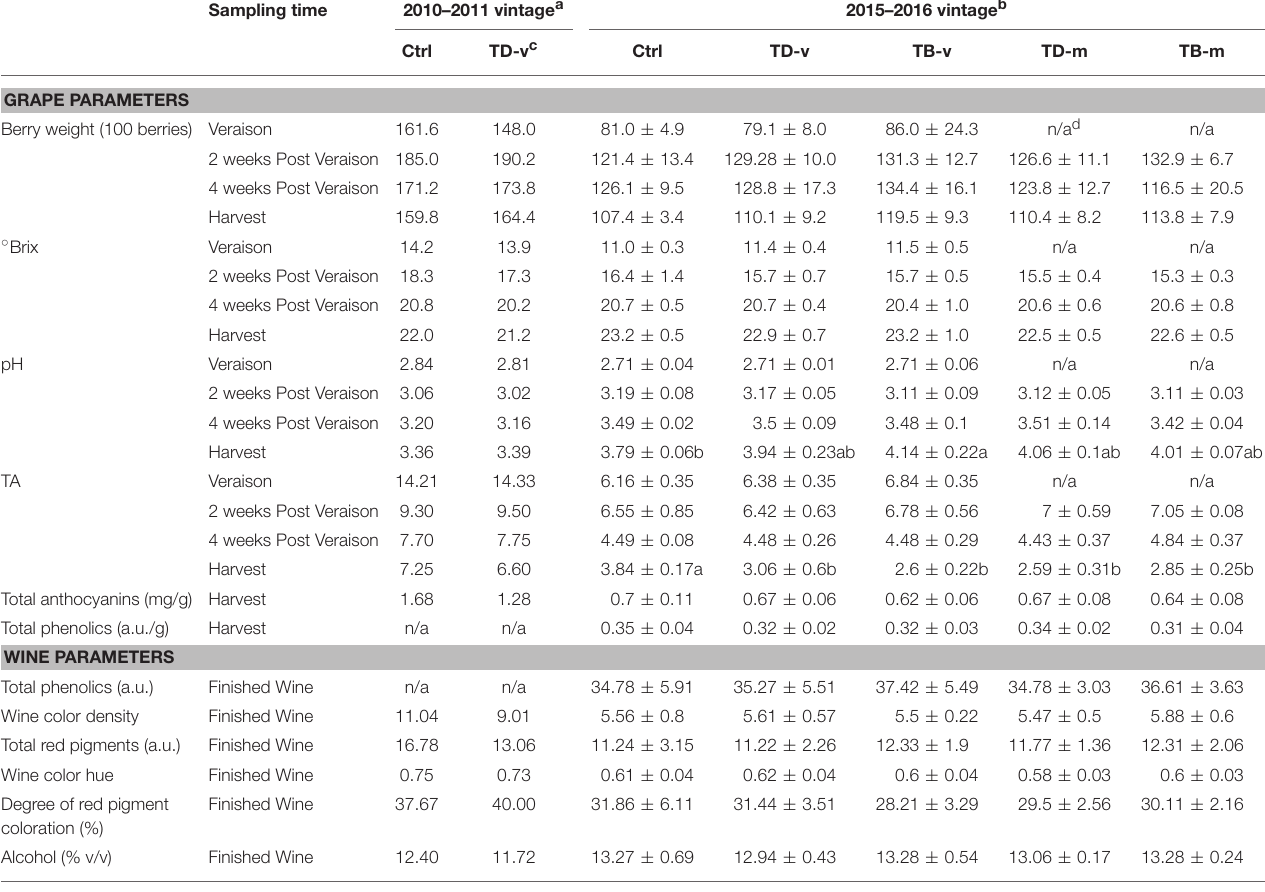
TABLE 1 | Summary of grape and wine chemical parameters. Sampling